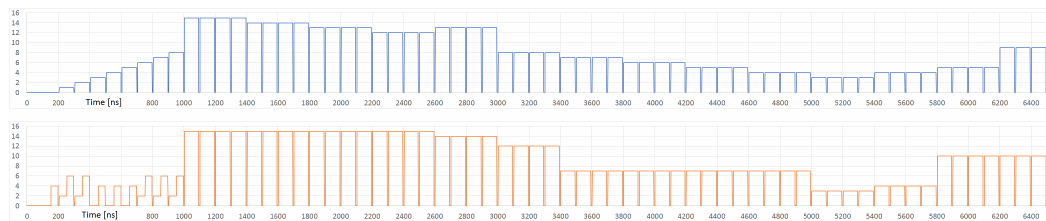
Figure 16. Input In1 and In2 signals recalculated to decimal numbers.